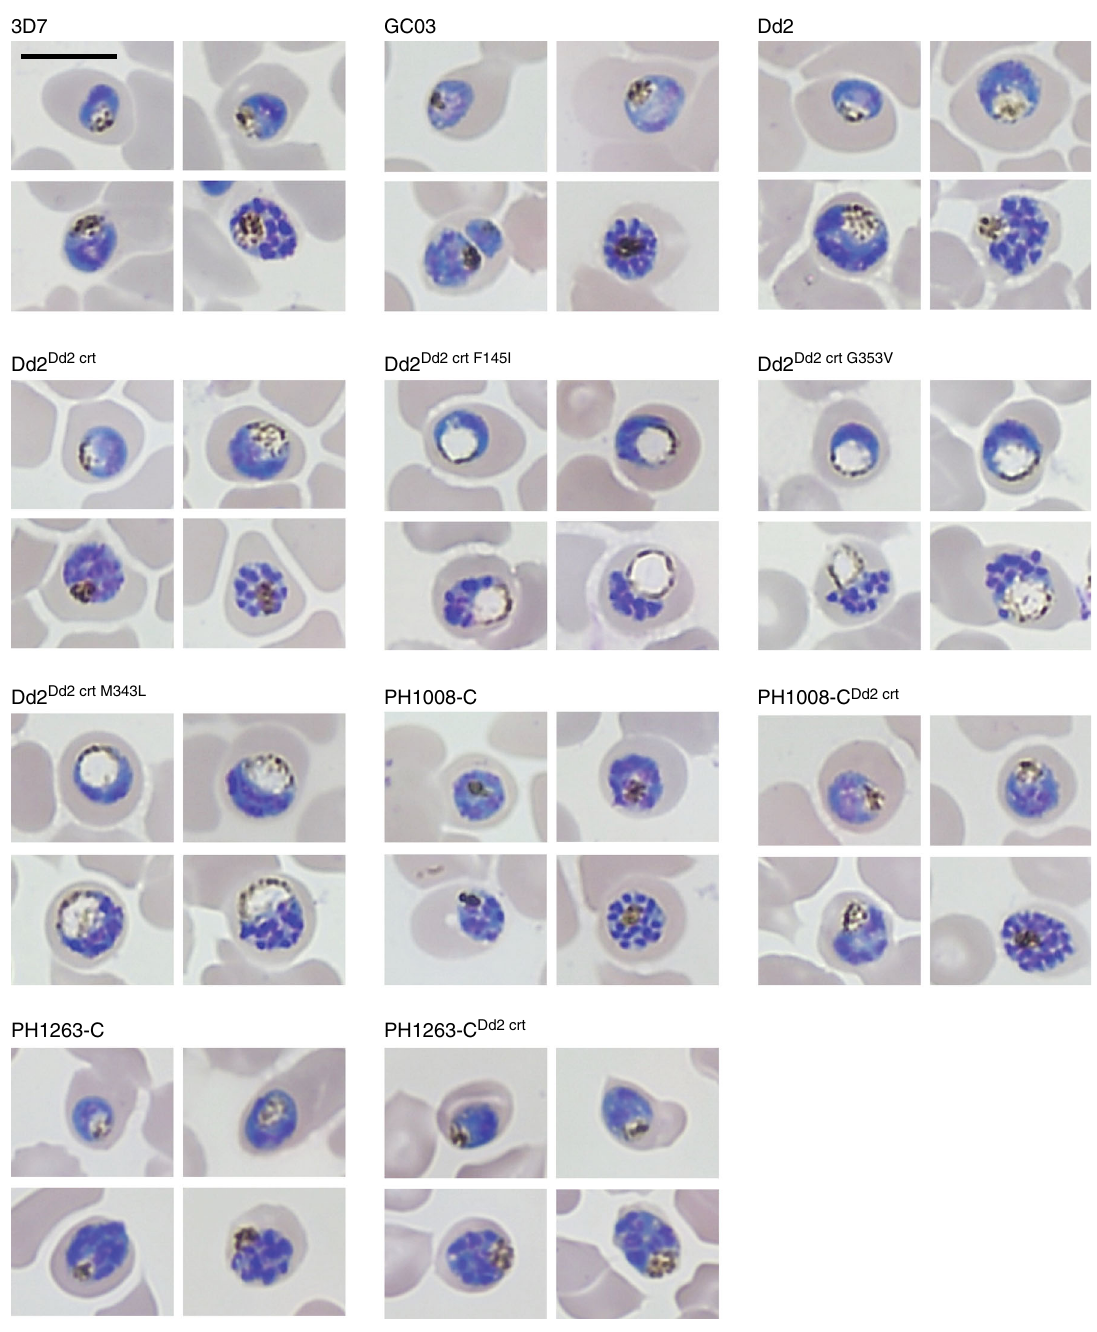
Fig. 7 Cell morphology of pfcrt -edited and parental parasite lines. Images reveal distended, translucent digestive vacuoles in Dd2 parasites expressing novel PfCRT variants. These aberrant morphological features were not observed in recent Cambodian isolates harboring novel variants. The scale